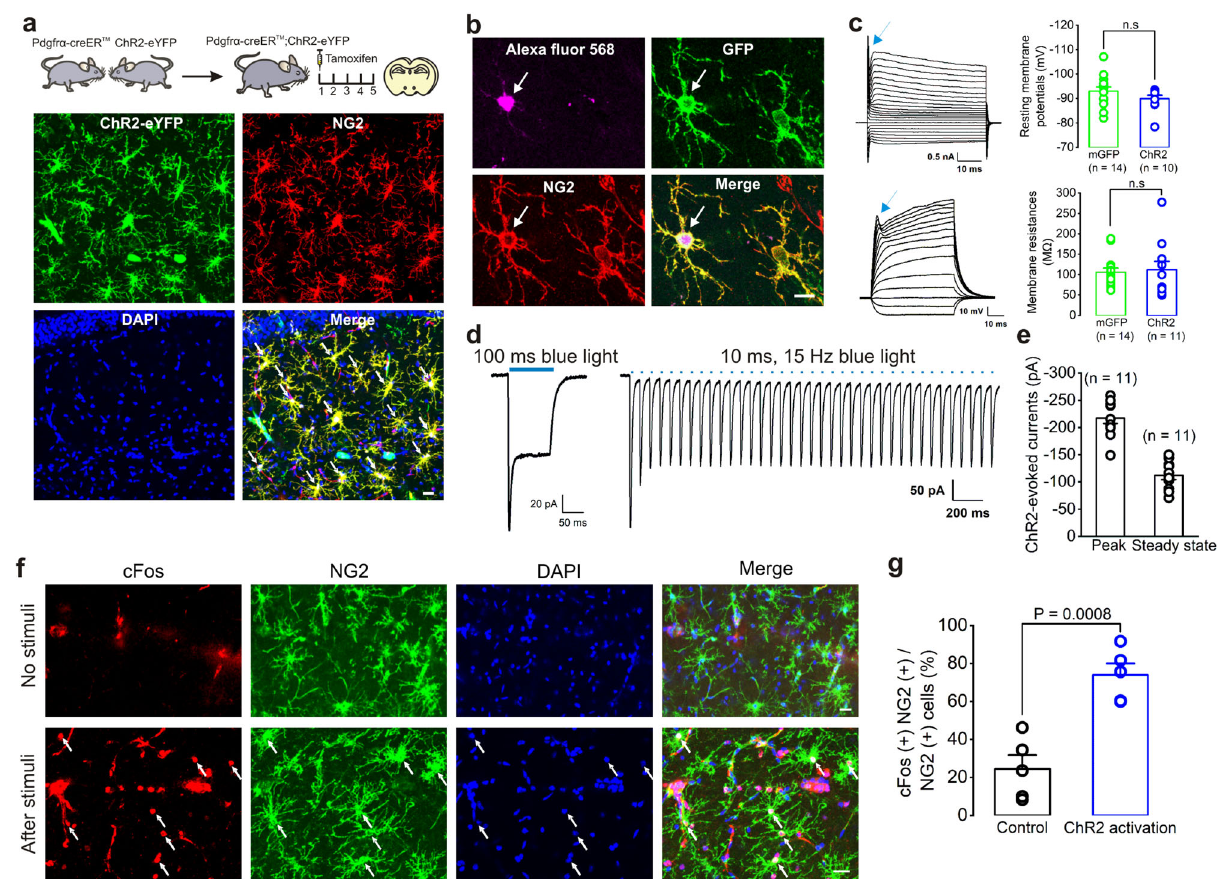
Fig. 1 Speci fi c activation of NG2 glia by optogenetic stimulation. a Cartoon illustrating the procedure for generating transgenic mouse line by breeding Pdgfr α -creER TM with ChR2(H134R)-eYFP (Ai32) mice to induce ChR2 expression in NG2 glia after consecutive 5-day tamoxifen injections. The immunohistochemistry images below show the ChR2-eYFP labeling (in green) is speci fi cally expressed in NG2 antibody-labeled NG2 glia (in red) in adult hippocampus from Pdgfr α -creER TM ;ChR2(H134R)-eYFP mice at postnatal 4 – 6 weeks. The colocalization is indicated by arrows. Scale bar, 20 μ m. b Representative images show a whole-cell patched NG2 glia expressing ChR2-eYFP loaded with Alexa Fluor 568 in the patch pipette in the stratum radiatum region of the adult hippocampus at P30 and identi fi ed with post-immunostaining of NG2 antibody. The colocalization is indicated by arrows. Scale bar, 20 μ m. c Whole-cell voltage-clamp and current-clamp recordings from NG2 glia showing a typical sodium channel current depolarization but not generating action potentials as the arrows indicate (voltage steps: – 160 – 70 mV, 10 mV/step; current steps: − 200 – 1200 pA, 100 pA/step). The summary bar graphs show there is no change of the cell membrane properties after ChR2 expression in NG2 glia compared with its mGFP control (resting membrane potentials for mGFP, − 93.0 ± 1.7 mV, n = 14 cells; ChR2, − 89.9 ± 1.4 mV, n = 10 cells, Mann – Whitney test, P = 0.1721; membrane input resistances for mGFP, 105.5 ± 10.3 M Ω , n = 14 cells; ChR2, 112.1 ± 20.8 M Ω , n = 11 cells, two-tailed unpaired t test, P = 0.7645). d Representative traces show that a 100 ms blue light pulse or 10 ms 15 Hz light pulses stimulation at 5 mW/mm 2 illumination intensity induces one or a series of non-degrading photocurrents in NG2 glia from Pdgfr α -creER TM ; ChR2 mouse hippocampus at postnatal 4 – 6 weeks. e Bar graph summarizing the peak and steady-state ChR2-evoked photocurrents in NG2 glia. n = 11 cells. f Representative images of cFos staining in NG2 glia before and after ChR2 photoactivation. The arrows indicate a signi fi cant increase of cFos-positive NG2 glia after blue light stimuli in acute hippocampal slices at postnatal 4 – 6 weeks. Scale bars, 20 μ m. g Summary graph shows the percentage increase of cFos-positive NG2 cells in a whole population of NG2 glia after photostimulation. No blue light stimuli: 24.5 ± 7.23%; After blue light stimuli: 73.8 ± 6.14%, n = 5 mice, two-tailed unpaired t test, P = 0.0008. Data are presented as mean values ± SEM and the error bar represents bicuculline and 1 μM TTX, we found that neither interneurons ’ nor pyramidal neurons ’ mEPSCs were altered after NG2 glia photo- activation (Supplementary Fig. 4, n = 12 and 11 for interneurons and pyramidal neurons, respectively), indicating no or non- measurable effects from photostimulated oligodendrocytes. GABA A Rs mediate two distinct types of inhibition in the brain: phasic and tonic. Phasic inhibition, as represented by IPSCs, arises due to the release of GABA from presynaptic neurons and tonic inhibition arises due to the persistent activation of extrasynaptic GABA A Rs in response to ambient and synaptic GABA spillover 16,34,35 . To determine how NG2 glia photoactiva- tion affects interneurons ’ inhibitory synaptic activity, we applied 20 μ M bicuculline in the presence of DNQX and AP5 to evoke